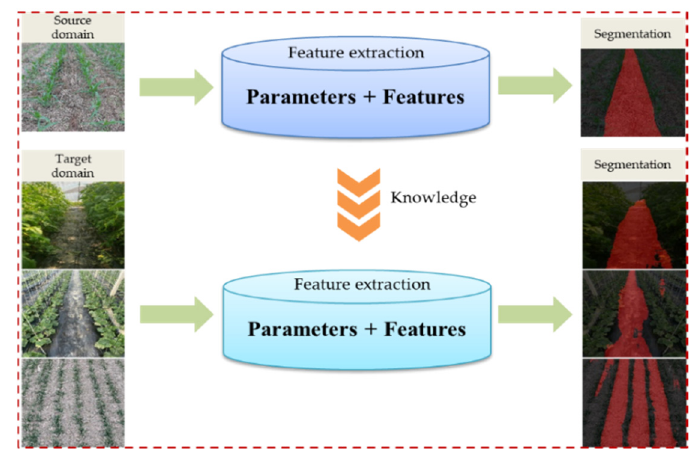
Figure 6. Visual transfer learning.